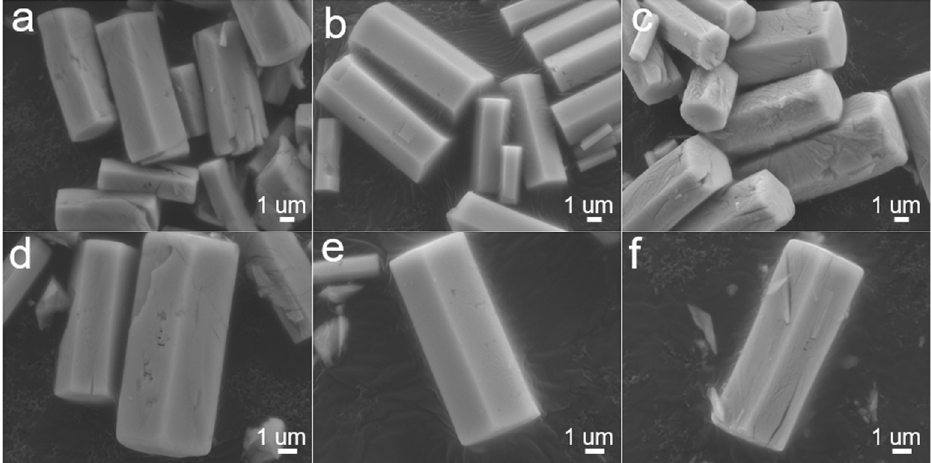
Figure 2. SEM images of ( a , d ) Sample B: α /h-MoO 3 , ( b , e ) Sample A: h-MoO 3 , and ( c , f ) Sample C: α -MoO 3 , respectively.